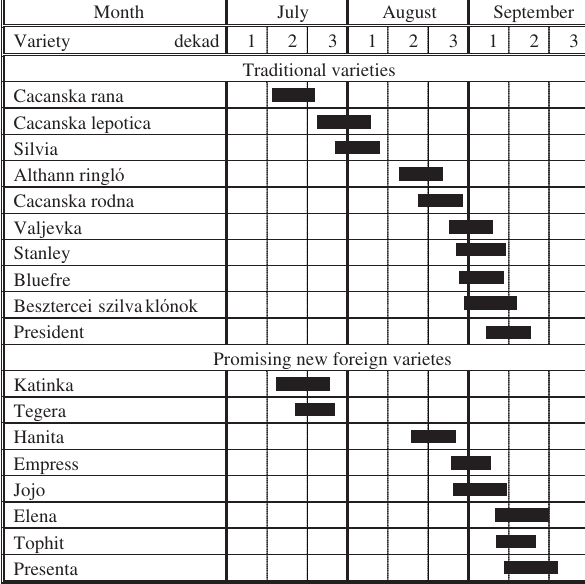
Figure 1. Periods of maturity in plum